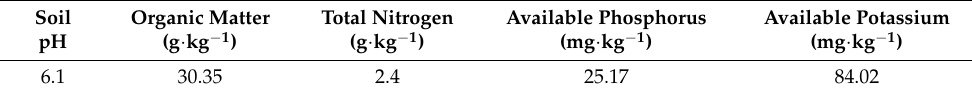
Table 5. Physical and chemical properties of the experimental